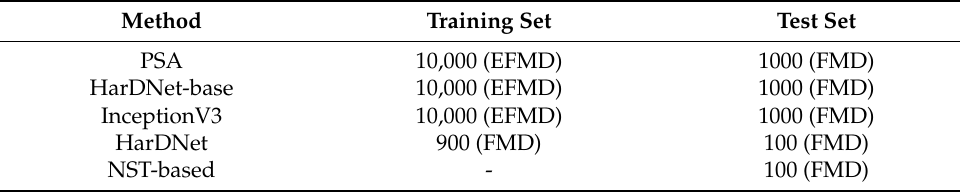
Table 1. Number of training and testing images used for each